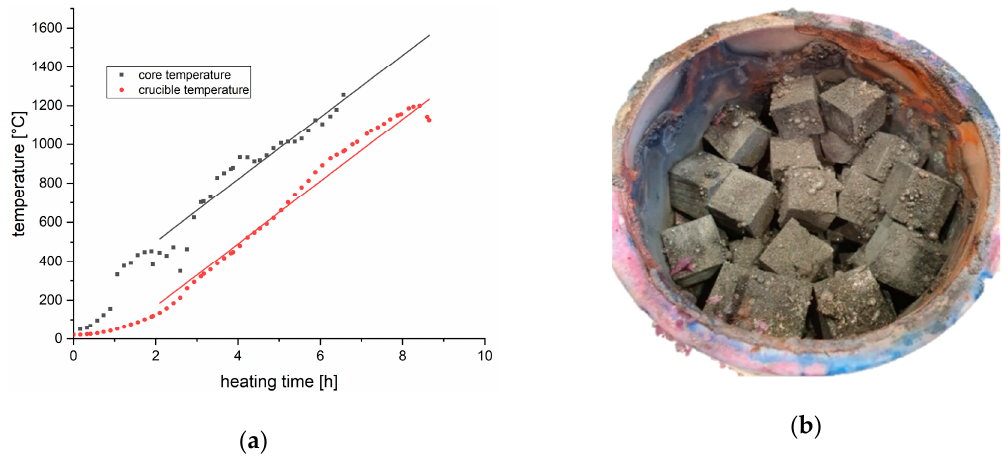
Figure 8. ( a ) Trend of reactor temperatures during IM_NMC_C. ( b ) Picture showing the crucible and the packed bed of graphite cubes with metal depositions after